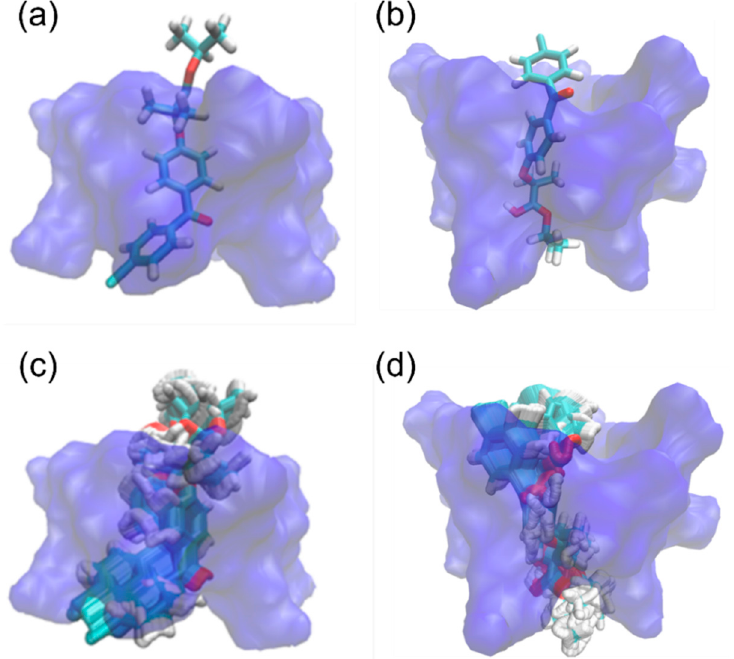
Figure 4. Based on molecular docking, the binding orientations of the FE/RM β CD complex were labelled as form I ( a ) and form II ( b ). The surface representation in blue denotes the RM β CD molecule, and the licorice representation denotes the FE molecule. Meanwhile, the movements of FE in the RM β CD cavity are labelled as form I ( c ) and form II ( d ). The surface representation in blue denotes the RM β CD molecule, and the licorice representation denotes the FE molecule.